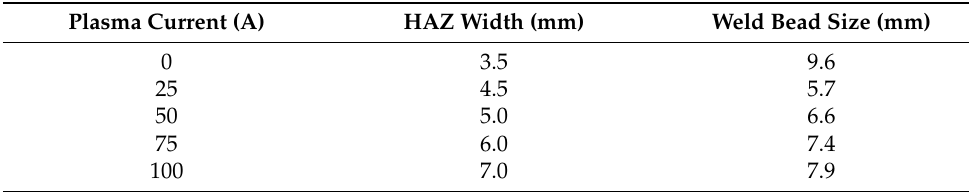
Table 4. HAZ widths and weld bead size for different plasma